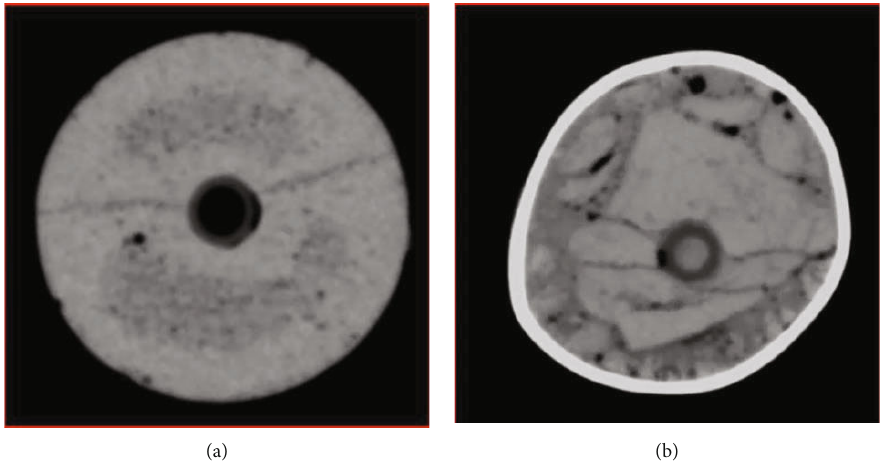
Figure 8: Crack patterns seen from CT scans along horizontal cross sections on samples A and B.